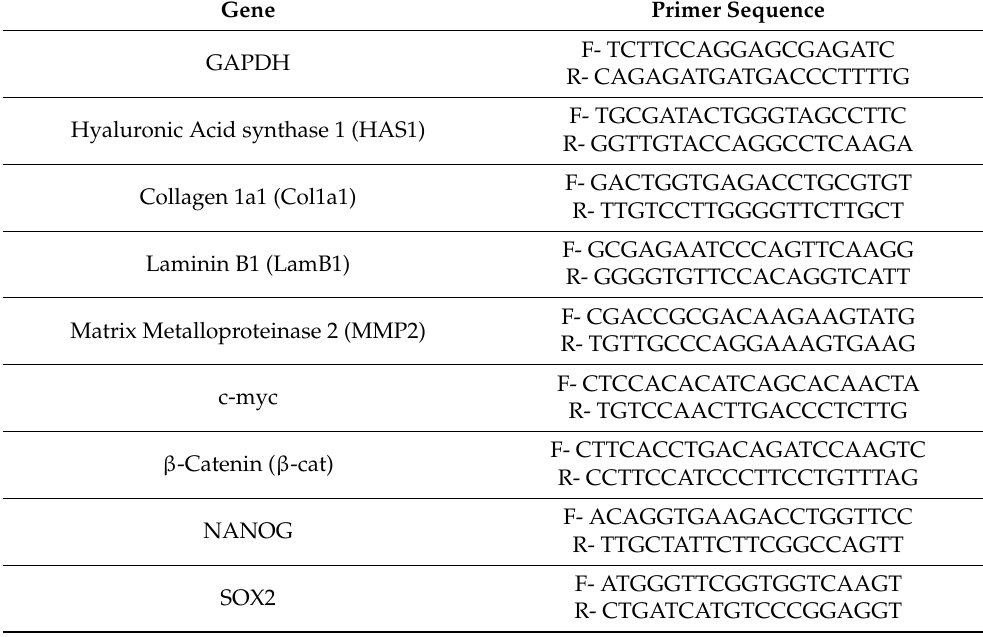
Table 1. Primers for polymerase chain reaction (PCR) amplification. F: forward; R: reverse. Gene Primer Sequence F- TCTTCCAGGAGCGAGATC GAPDH R- CAGAGATGATGACCCTTTTG F- TGCGATACTGGGTAGCCTTC Hyaluronic Acid synthase 1 (HAS1) R-